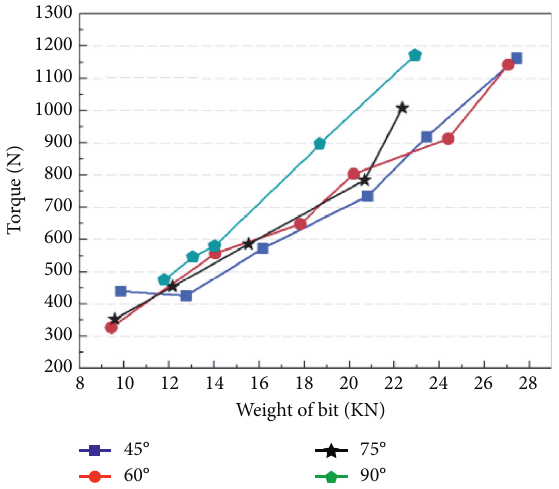
Figure 29: Relationship between WOB and torque with α change of bits (sandstone).